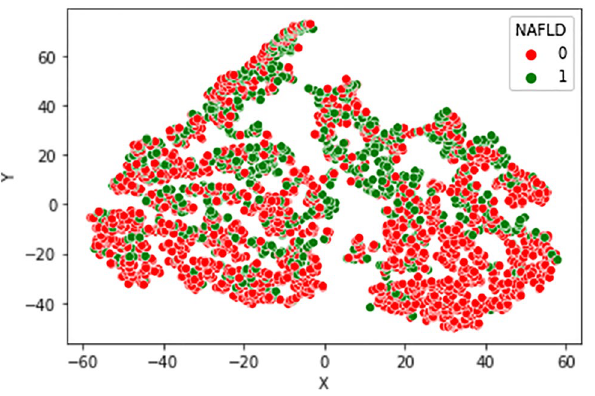
Figure 1. Visualizing data with